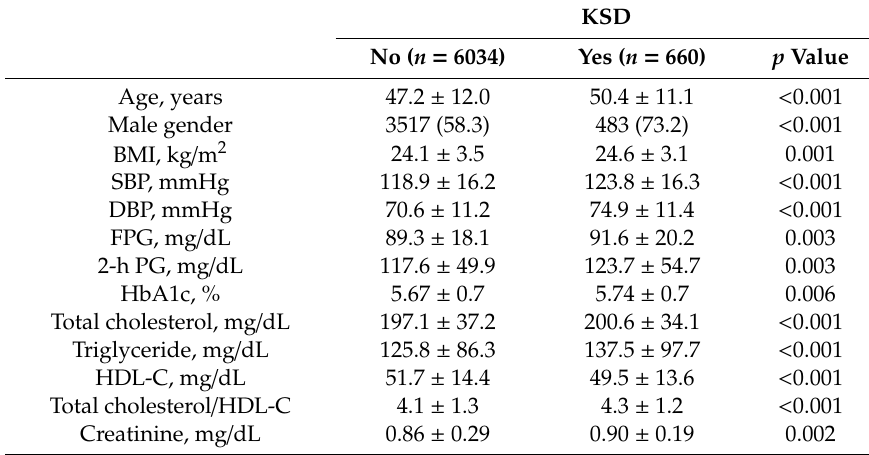
Table 2. Comparisons of clinical characteristics between subjects with and without kidney stone disease